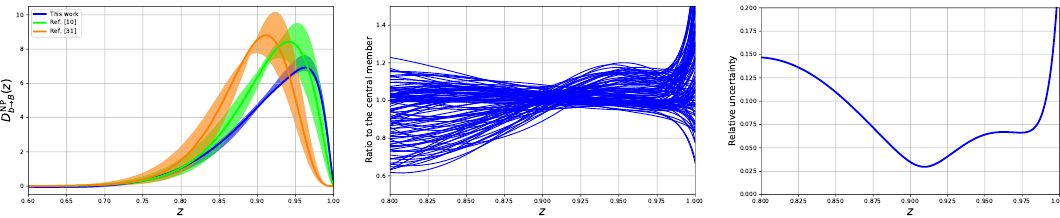
Figure 5 . Left: a comparison of the new NPFF fit (blue) with the one from ref. [31] (orange) and ref. [10] (green). The error bands correspond to one standard deviation. Center: the ratio plot of the full new NPFF set to its central member, and (right) the relative r.m.s. of the new NPFF